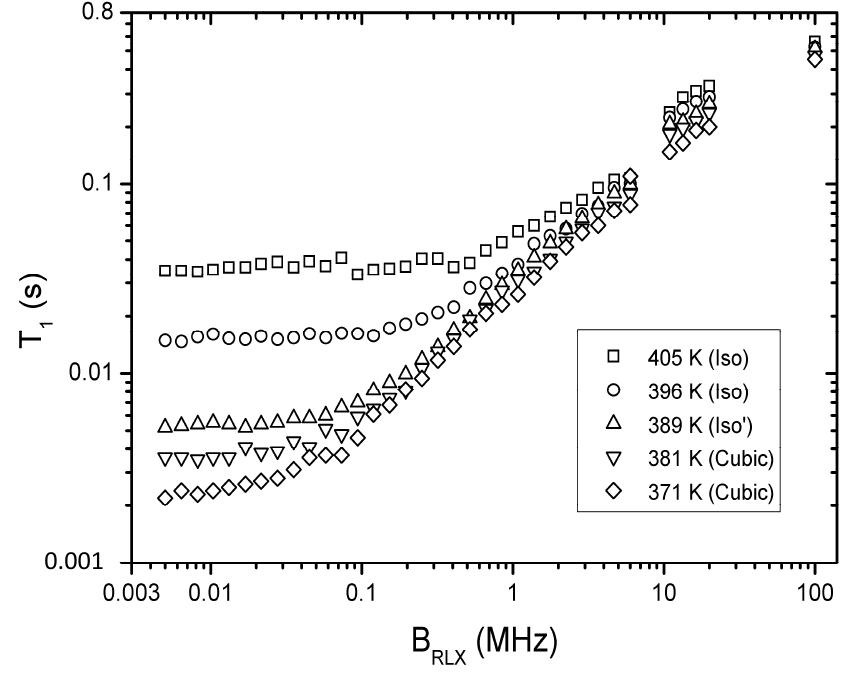
Figure 6. Frequency (MHz) dependence of proton spin-lattice relaxation time T 1 (s) of L1 at some chosen temperatures in the three mesophases: isotropic, isotropic’, and cubic